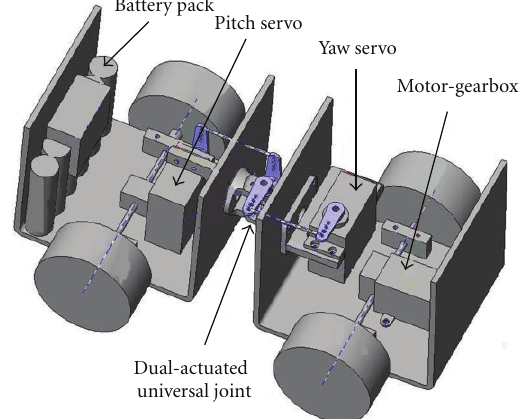
Figure 5: The design of the articulated-steering mobile robot.